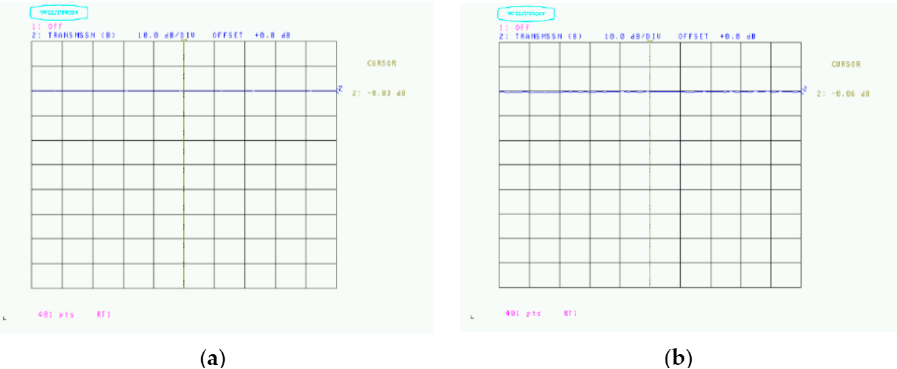
Figure 11. Changes in the amount of radio wave absorption depending on the board: ( a ) Calibration ( − 0.02 dB); ( b ) Foamed polypropylene ( − 0.06